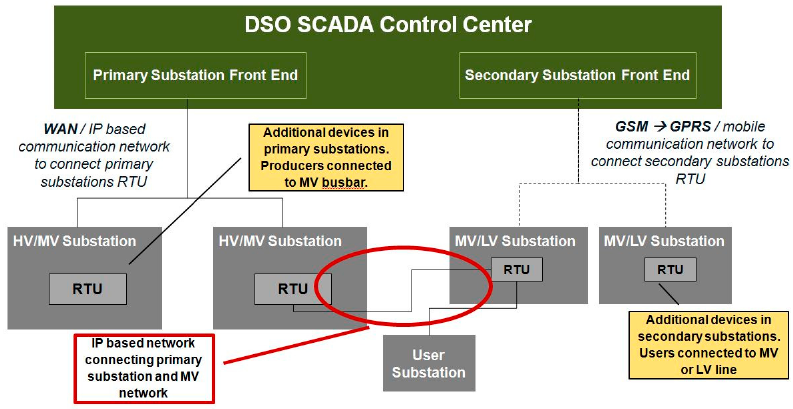
Figure 2. Evolved Smart Distribution System Operator’s (DSO) SCADA.